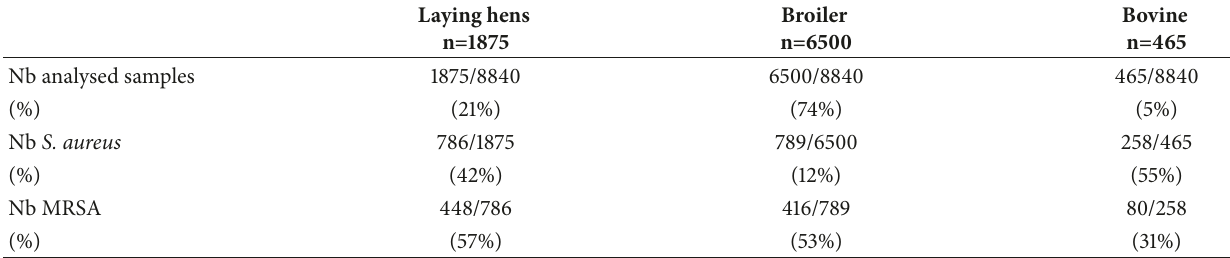
Table 2: Distribution of S. aureus and MRSA strain. Laying hens